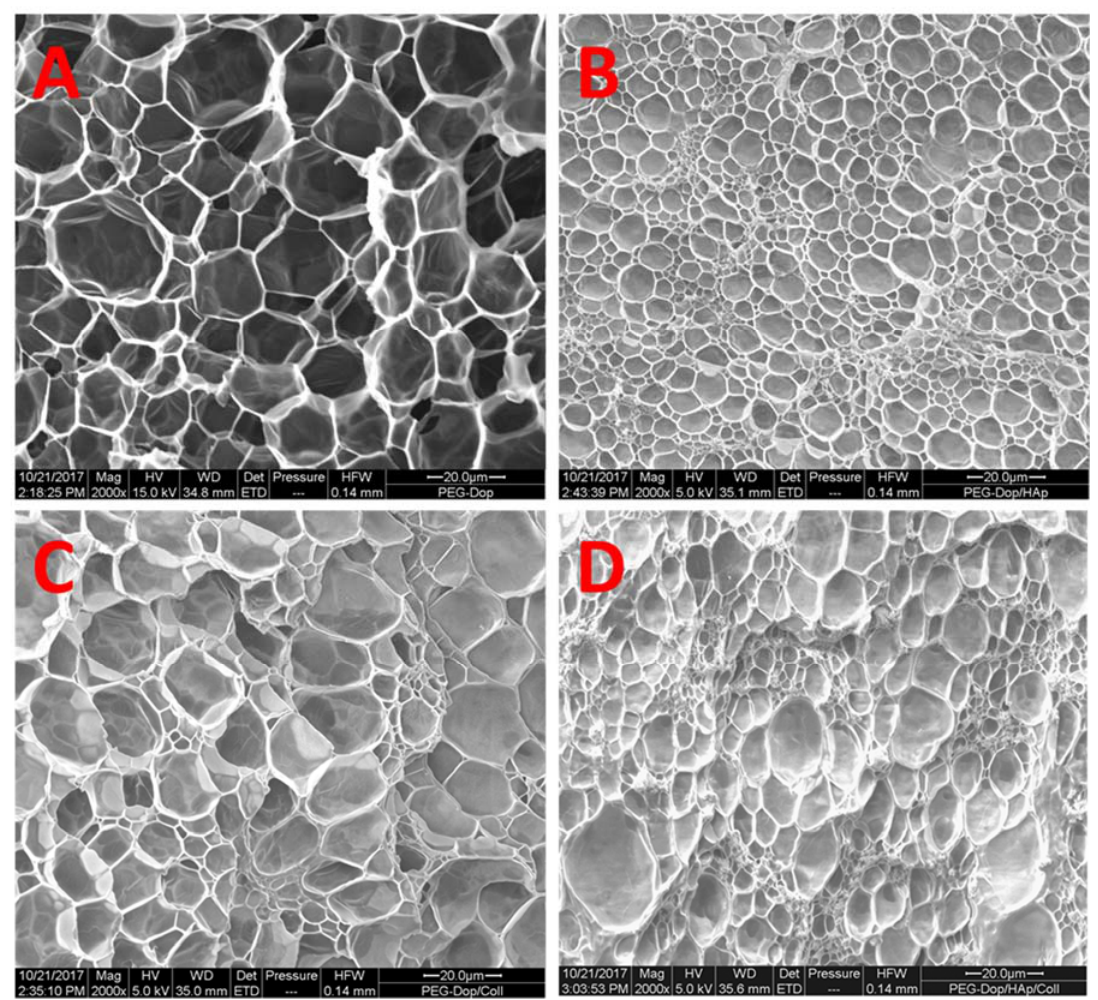
Figure 5. Scanning electron microscopy (SEM) images of the bulk structure of ( A ) PEG ‐ Dop; ( B ) PEG ‐ Dop/HAp; ( C ) PEG ‐ Dop/Coll; ( D ) PEG ‐ Dop/HAp/Coll. Concentration of the different components was: 15% ( w / v ) PEG ‐ Dop, 2.5% ( w / v ) HAp, 0.1% ( w / v ) Coll. In all cases, scale bar: 20 μ m.